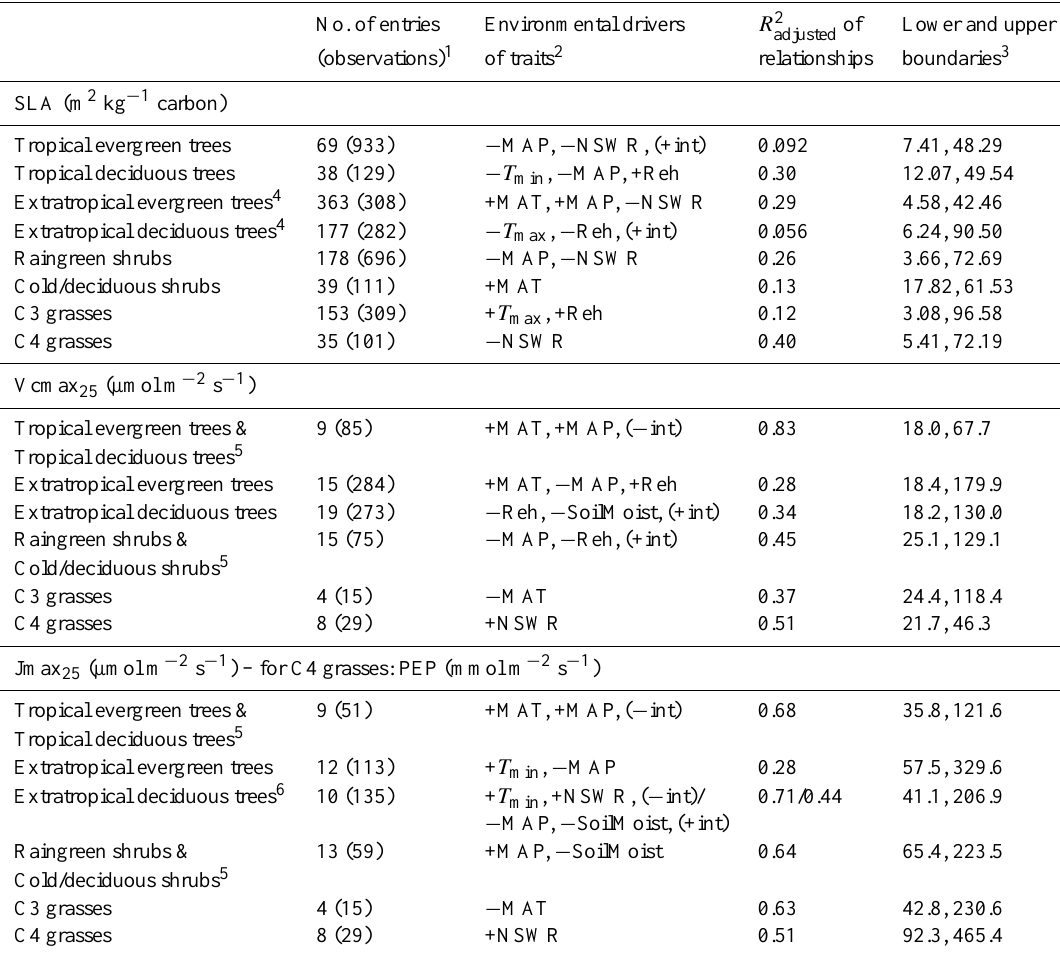
Table 2. Properties of the selected trait–climate relationships used to parameterize